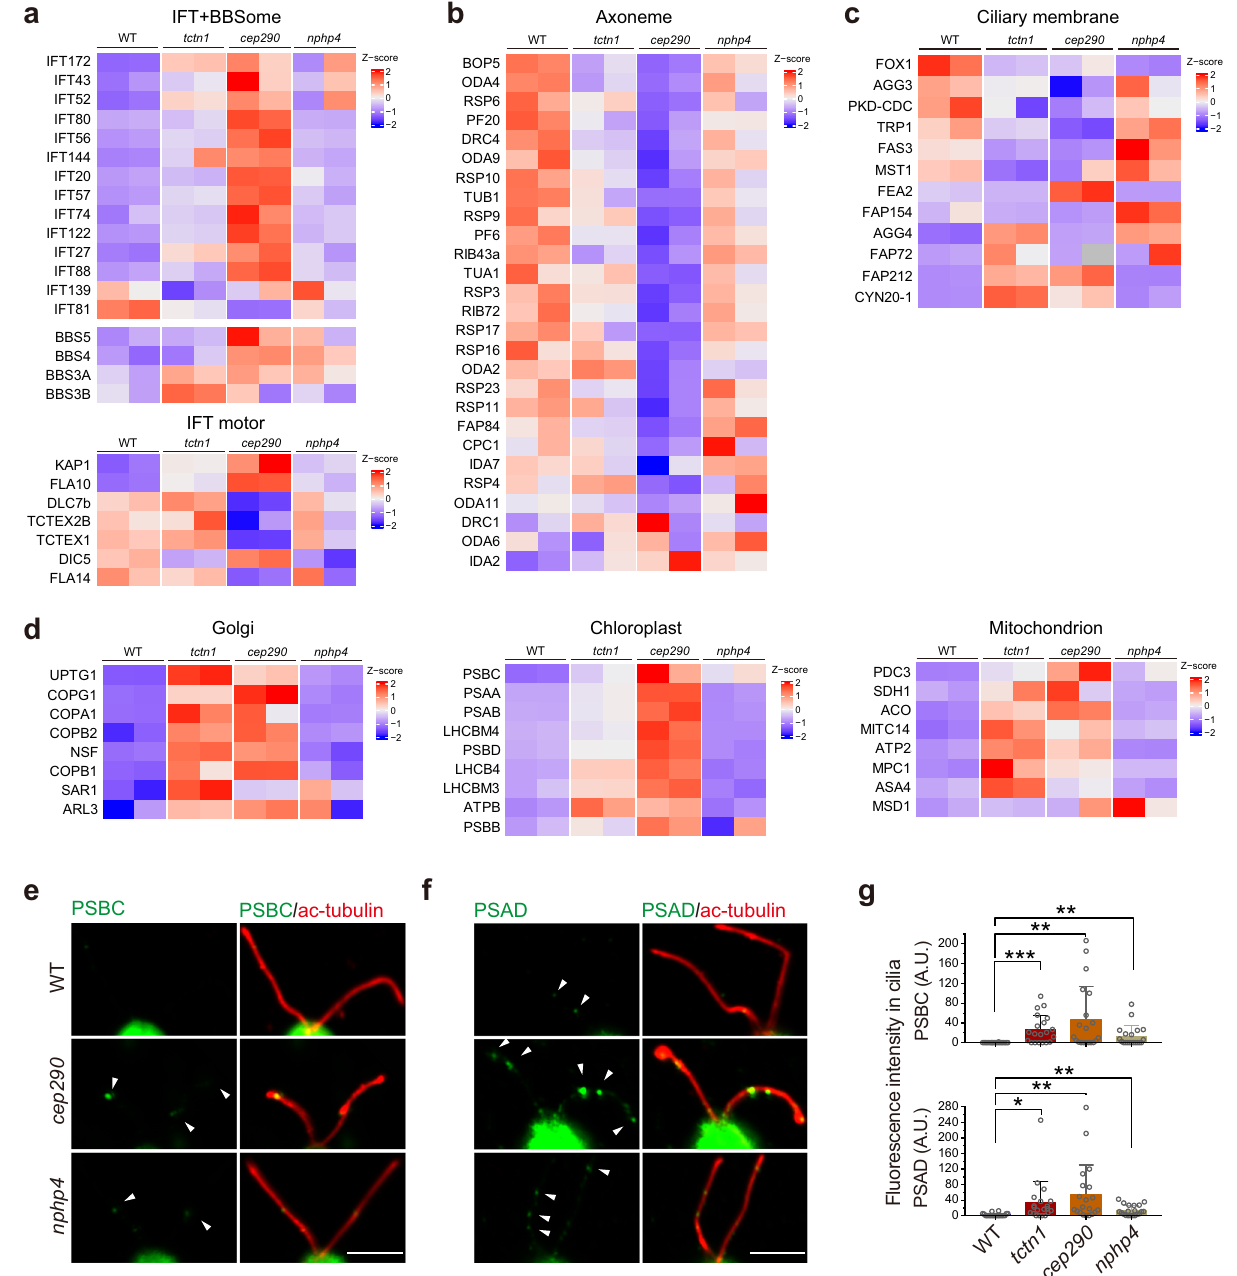
Fig. 5 Proteins differentially regulated in cilia by different TZ proteins. a – d Heatmap of representative groups of proteins identi fi ed from ciliary proteomics analysis of cilia from WT, tctn1 , cep290 , and nphp4 cells (two replicates for each strain, column). Representative proteins were selected from the mass spectrometry data in Supplementary Fig. 6a and grouped into IFT and BBSome ( a , top), IFT motor ( a , bottom), Axoneme ( b ), Ciliary membrane ( c ), Golgi ( d , left), Chloroplast ( d , middle), and Mitochondrion ( d , right) proteins. The Z – score is shown by color key in the heatmaps. e , f Immunostaining images displaying the enrichment of photosystem proteins (PSBC and PSAD) in TZ mutants ( cep290 and nphp4 ). WT and TZ mutants were immunostained with anti-PSBC ( e , green), or anti-PSAD ( f , green) and anti-acetylated α -tubulin (ac-tubulin, red) antibodies. The non-ciliary proteins were transported and accumulated in cilia of TZ mutant cells. The arrowheads indicate the accumulations of photosystem proteins in the cilium. Scale bar, 5 μ m. g Bar – scatter graphs show the ciliary fl uorescence intensity (arbitrary units, A.U.) of PSBC or PSAD. Data are the mean ± SD ( n = 20). Statistical signi fi cance was determined with an unpaired t test. * P < 0.05; ** P < 0.01; *** P < 0.001 by two tailed. Source data are provided as a Source Data fi